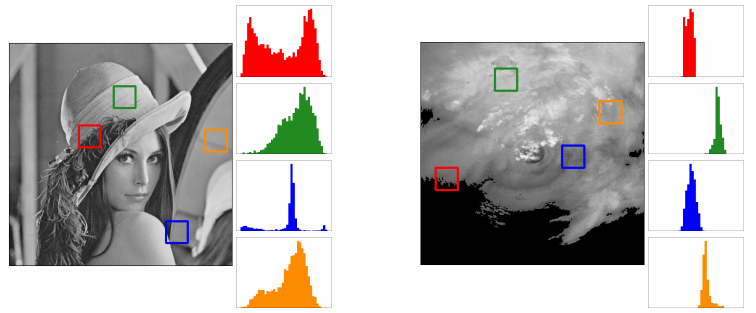
Figure 2. Distribution of random patches in a natural photo and a Doppler radar